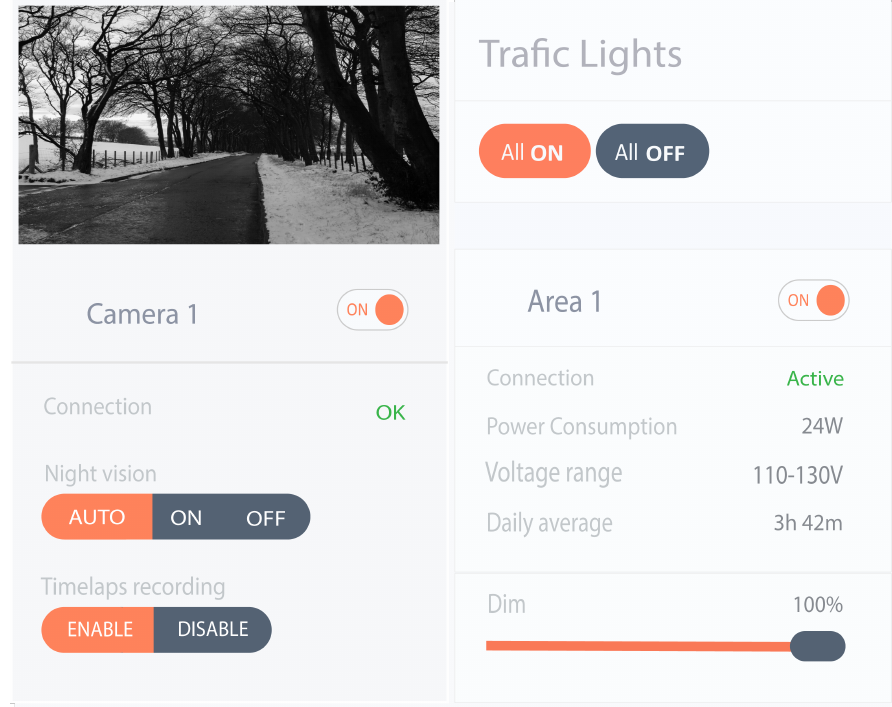
Figure 22. Resource description.